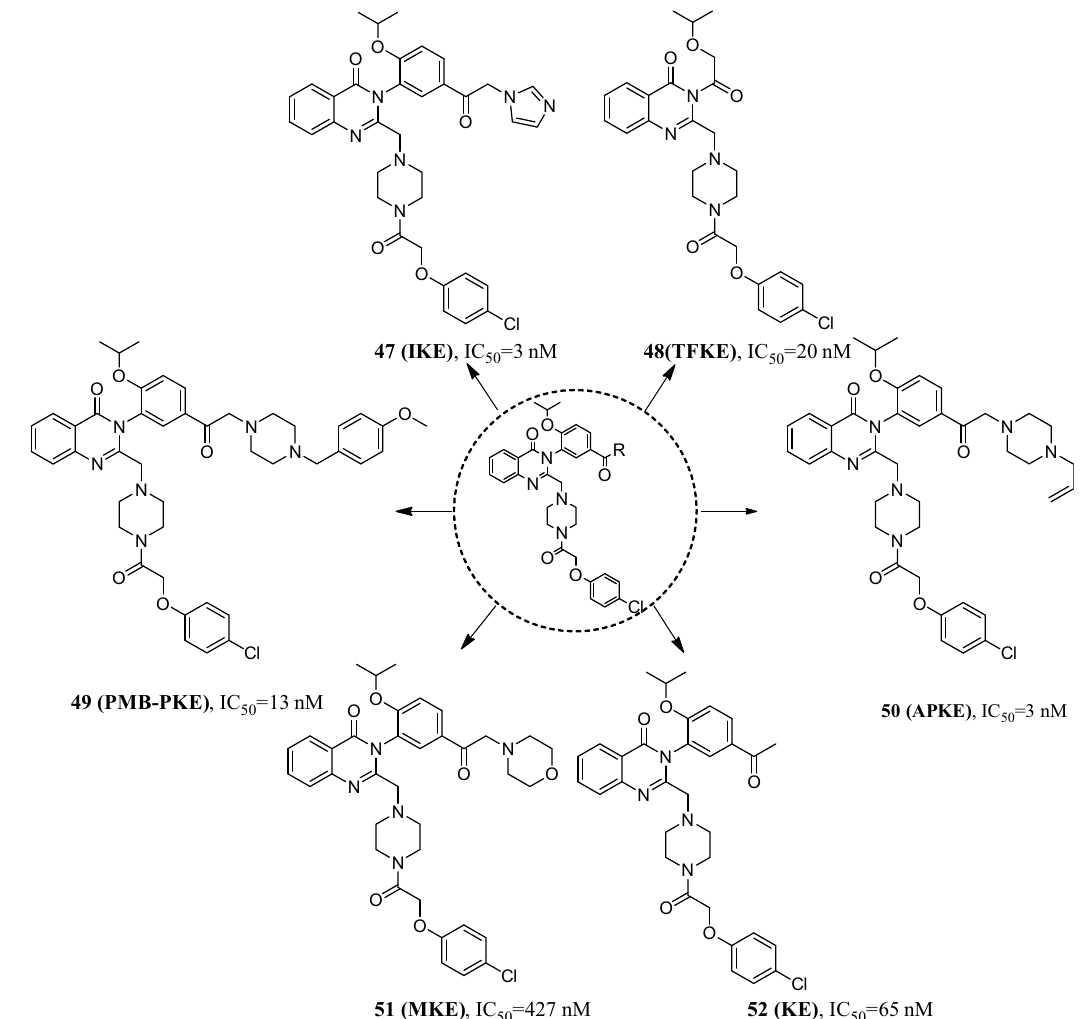
Figure 17: Chemical structures of compounds 47 –